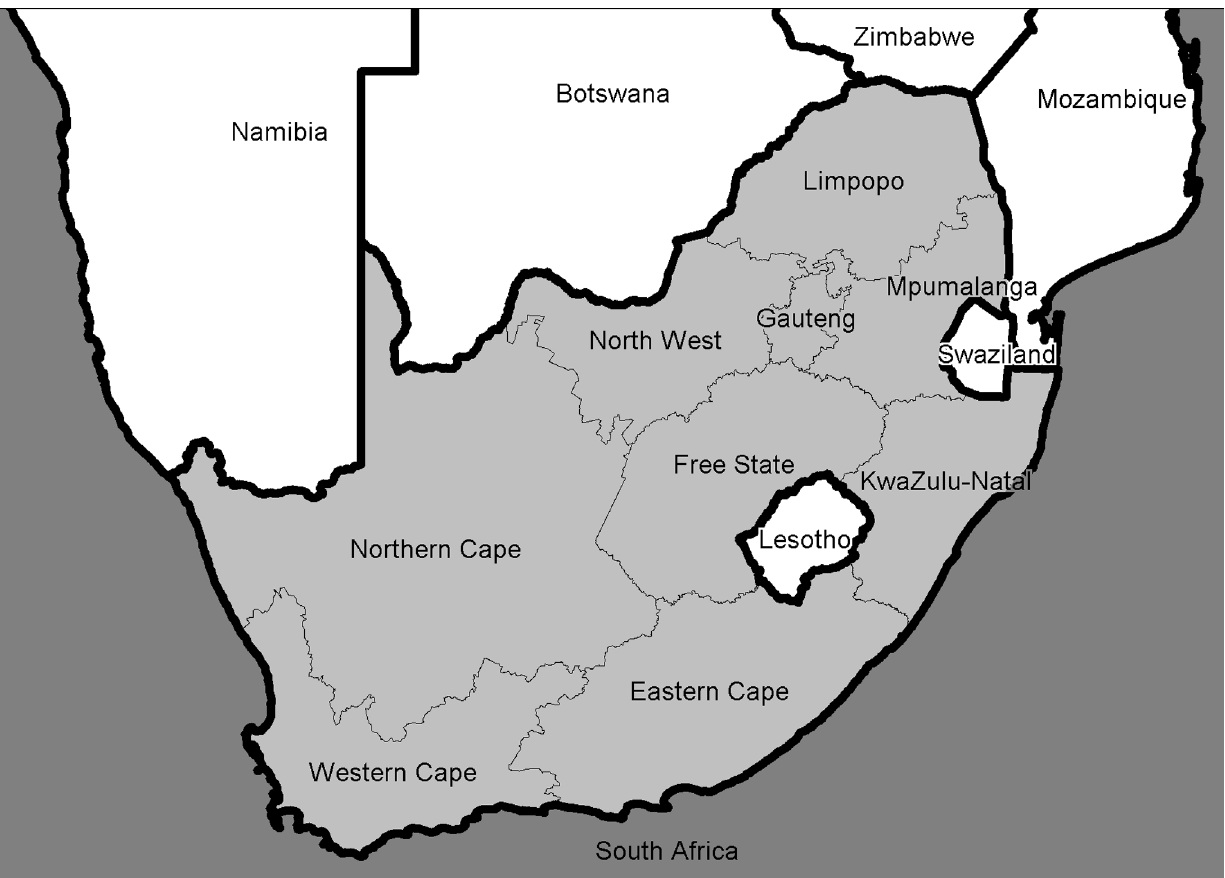
Figure 1. Map of South Africa, with provinces and neighbouring countries.